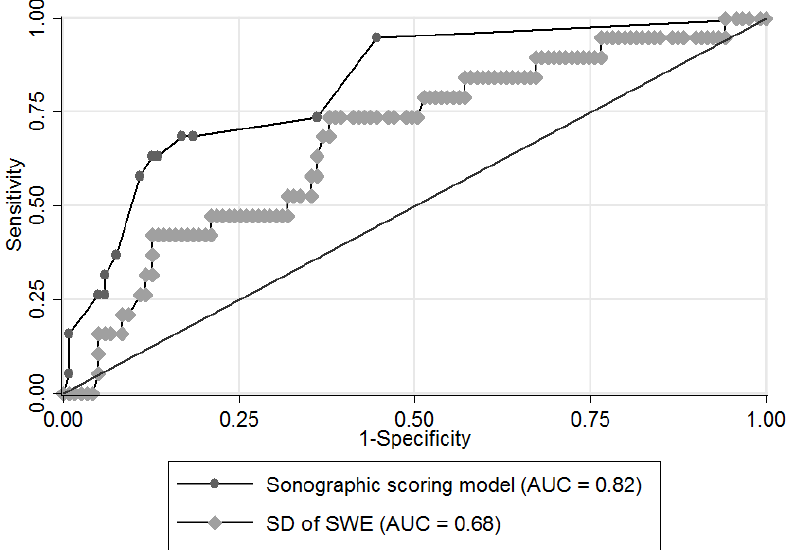
Figure 3. Comparison of ROC curves of the sonographic scoring model and the standard deviation of elasticity for differentiating malignancy from benignancy. Abbreviation: ROC, receiver operating characteristic; SD, standard deviation; SWE, shear wave elastography; AUC, area under the ROC curve. Note. For diagnosing malignant salivary gland tumors, the AUCs were 0.82 in the sonographic scoring model and 0.68 in the SD of elasticity.